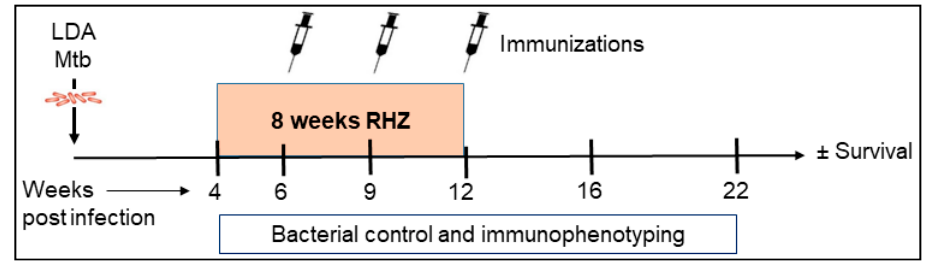
Figure 1. Preclinical mouse model of therapeutic vaccination against Mtb . SWR/J mice were challenged with a low-dose aerosol (LDA) of H37Rv Mtb . Four weeks post exposure, cohorts of mice were